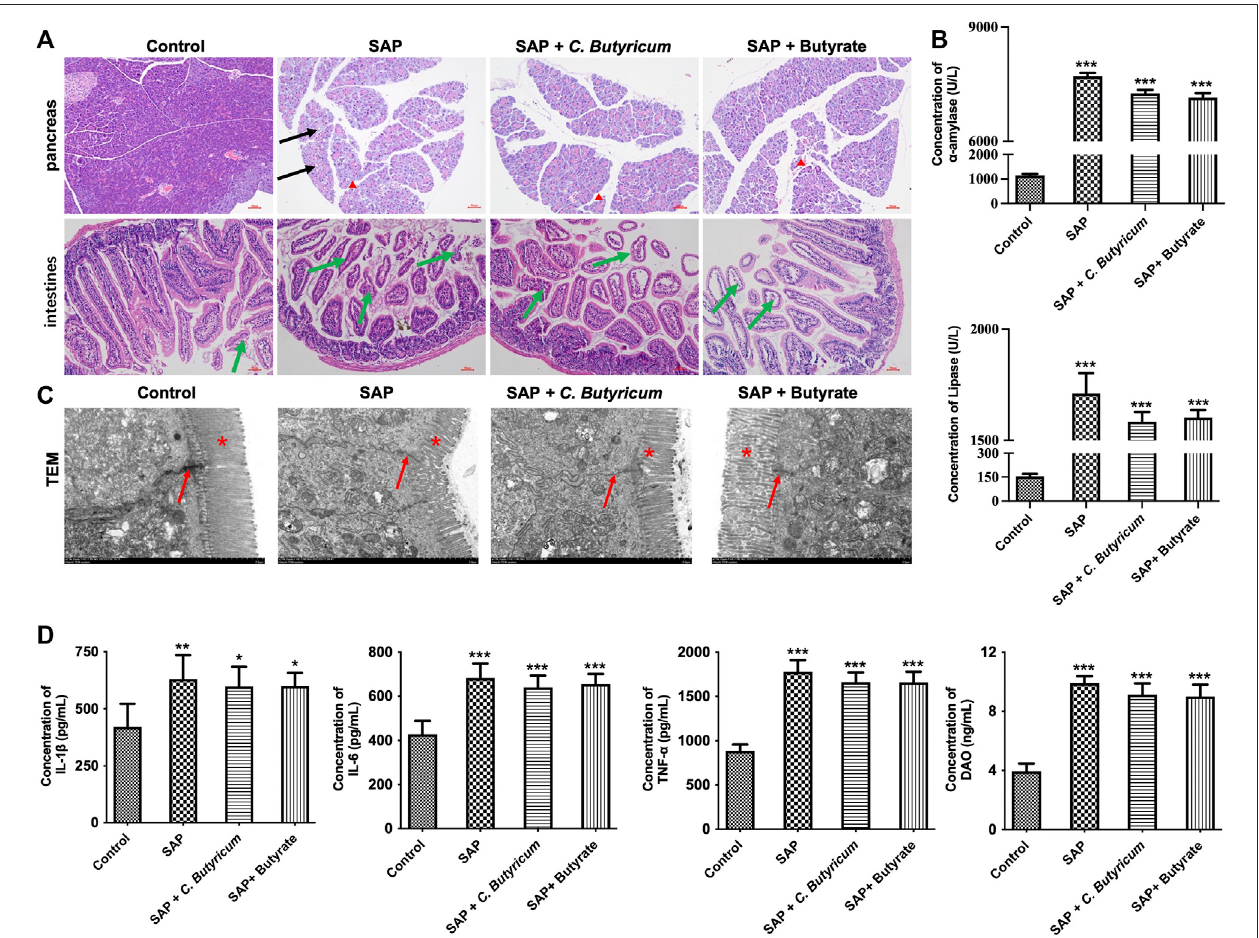
FIGURE 7 | Clostridium butyricum or butyrate could not exert protective roles on intestinal injury during SAP in MMP9 − / − mice. (A) H and E staining showed the pathological changes in the pancreas and smallintestine tissues. The black arrows denote acinar cells and the red triangledenote interstitial edema in pancreas tissues. The green arrows denote crypt atrophy in small intestine tissues. (B) ELISA assay was used to detect the levels of α -amylase and lipase in serum samples of MMP9 − / − mice. (C) The intestinal epithelial villi in MMP9 − / − mice was observed by TEM. The red arrow represents tight junctions; the red star represents intestinal microvilli. (D) The levels of IL-1 β , IL-6, TNF- α and DAO in serum samples of MMP9 − / − mice was detected by ELISA. * p < 0.05, ** p < 0.01, *** p < 0.001 vs. control group. diamine oxidase, DAO; MMP9, matrix metallopeptidase 9; SAP, severe acute pancreatitis; TEM, transmission electron microscope.